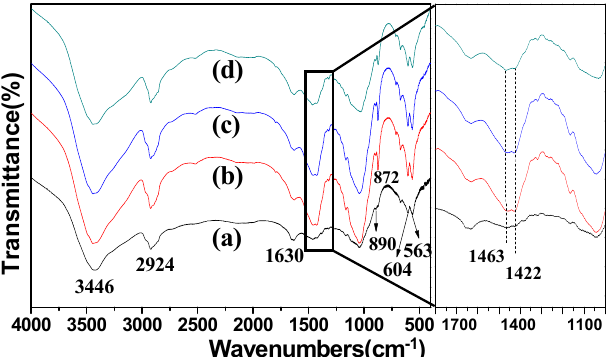
Figure 7. FT-IR spectra of the cellulose/HA nanocomposites prepared by microwave-assisted hydrothermal method at 180 °C for 10 min using different phosphorus sources: ( a ) NaH 2 PO 4 ·2H 2 O; ( b ) ATP; ( c ) CP; ( d ) FBP.